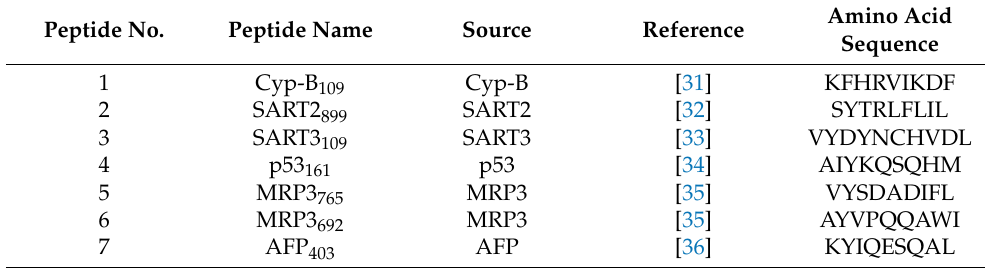
Table 2. The list of TAA-derived peptides analyzed. Peptide